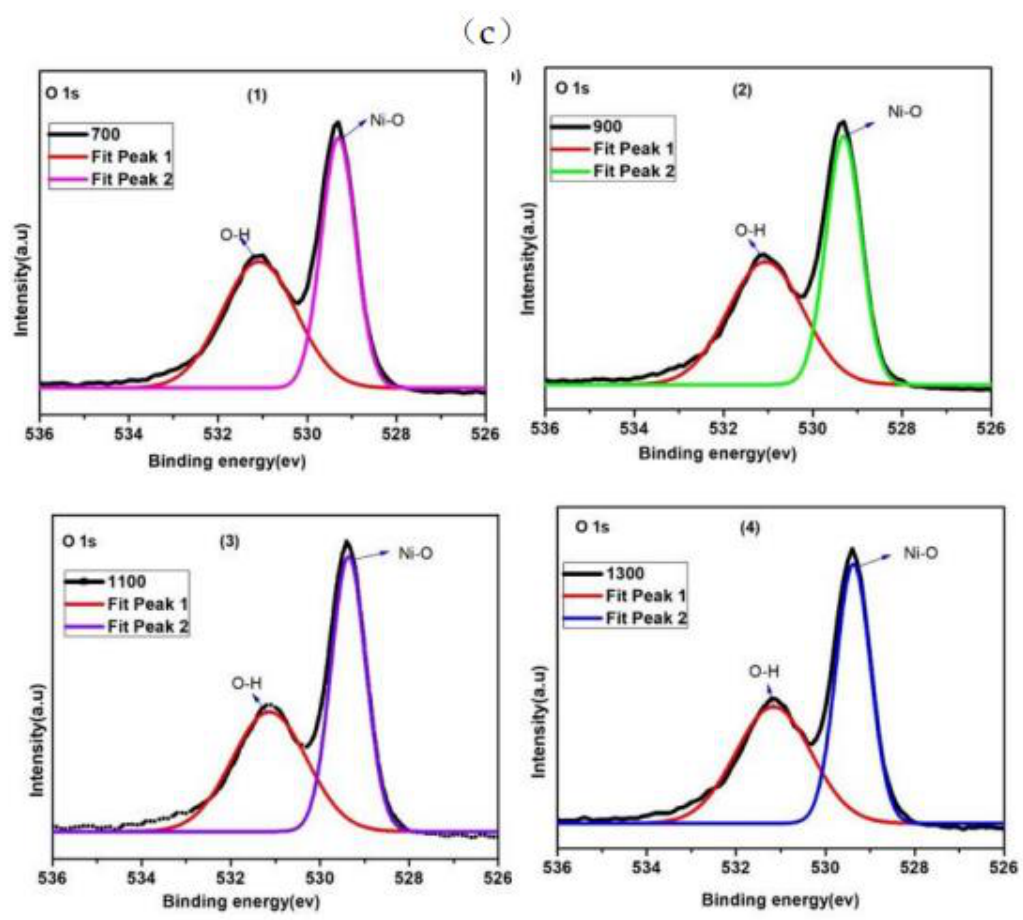
Figure 7. ( a ) XPS survey spectrum of green synthesized NiO thin films on Cu substrate prepared at rotational speeds (RS) of 700 RPM, 900 RPM, 1100 RPM, and 1300 RPM. ( b ) XPS spectra of Ni2p spectrum of green synthesized NiO thin films on Cu substrate prepared at rotational speeds (RS) of (1) 700 RPM, (2) 900 RPM, (3) 1100 RPM, and (4) 1300 RPM. ( c ) Typical XPS spectra of the O1s green synthesized NiO thin films on Cu substrate prepared at rotational speeds (RS) of (1) 700 RPM, (2) 900 RPM, (3) 1100 RPM, and (4) 1300 RPM.